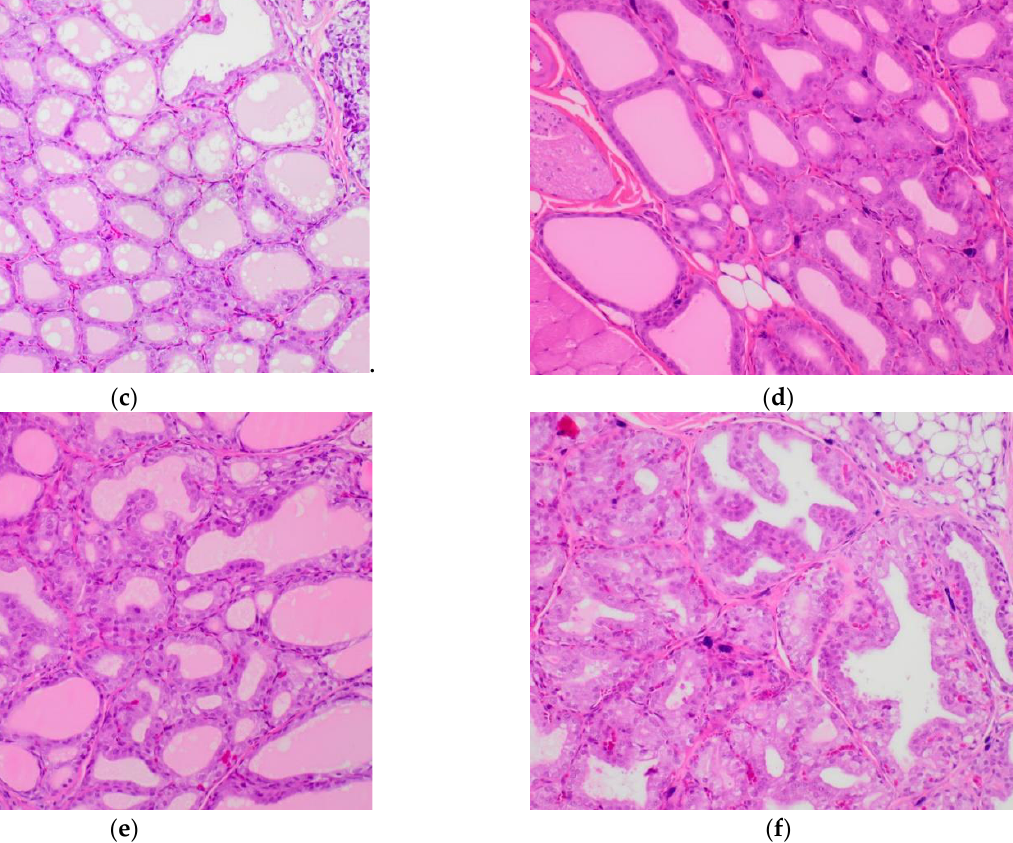
Figure 5. Histological appearance of the thyroid according to experimental group. All images were stained with hematoxylin – eosin at 200× magnification. ( a ) Group C: regular folliculi are lined by a rather flat epithelium and are full of colloid. ( b ) Group BS: folliculi are smaller with slightly higher cells. ( c ) Group DI: folliculi are also rather small and lined with cuboid cells, and the vacuolation of the colloid is prominent. ( d ) Group BS/DI: folliculi are smaller on the right and more dilated and lined by slightly flattened cells on the left. ( e ) Group S: variously sizes of folliculi, some with papillary projections. ( f ) Group BS/S: folliculi are smaller on the left and larger on the right; the papillary projections are evident.